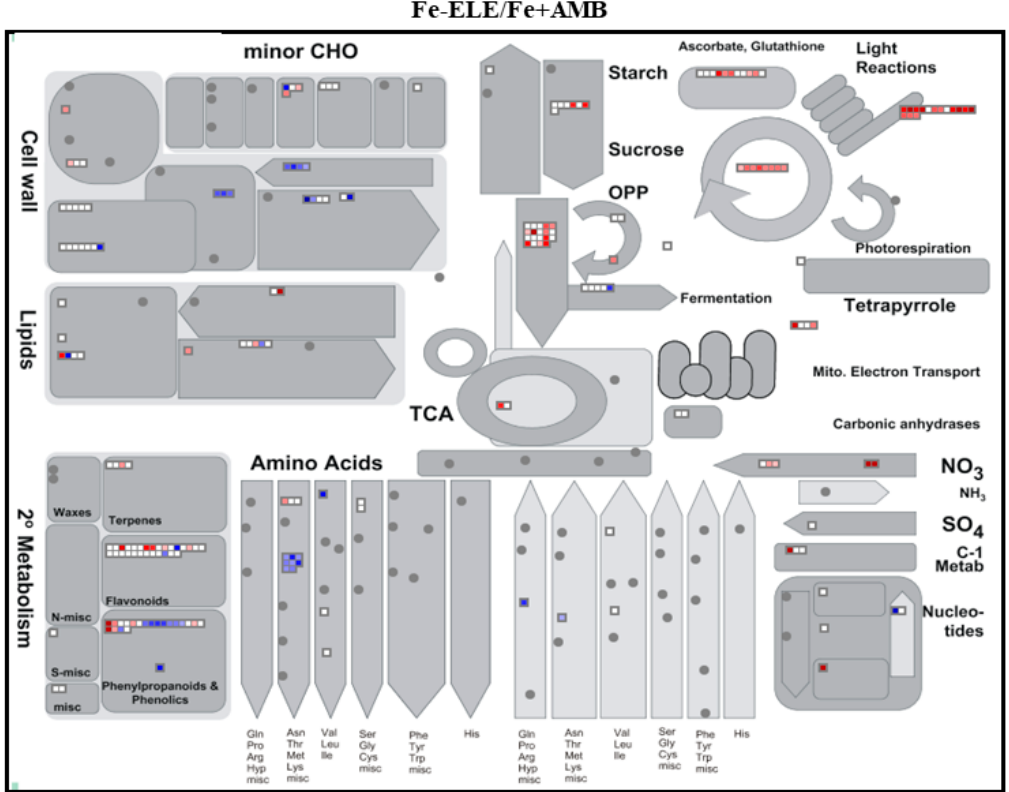
Figure 2. MapMan metabolism overview maps showing changes in DEPs in root tissues under eCO 2 and Fe-limitation. Fe+AMB, Fe-sufficient + aCO 2 ; Fe+ELE, Fe-sufficient + eCO 2 ; Fe-AMB, Fe-limitation + aCO 2 ; Fe-ELE, Fe-limitation + eCO 2 . Boxes represent log2 expression values, genes in red are upregulated, and those in blue are repressed.